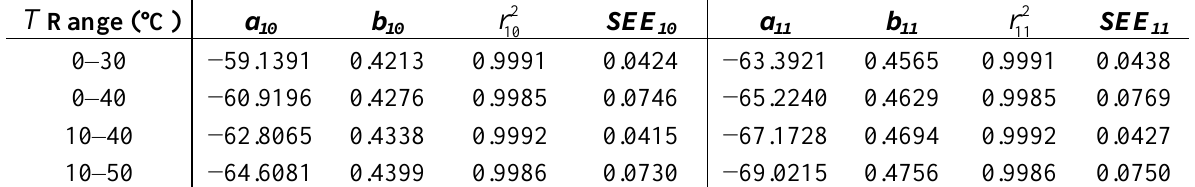
Table 1. Regression coefficients ( a , b ), coefficient of determination ( r 2 ), and Standard Error of Estimate (SEE) of the derivative of the Planck function, ∂ B , for Landsat-8 TIRS bands 10 and 11, for estimating parameter L at different ranges of temperatures ( T i